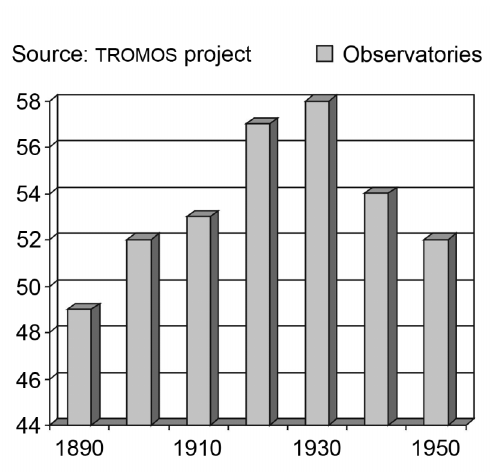
Fig. 1. Stations operating in Italy in the period 1900- 1950 (source TROMOS). Since the project made an inventory of observatories established before 1940, the histogram is updated to that time. The last bars of the plot takes into account only the stations that still existed in 1950 and does not include those established in the decade